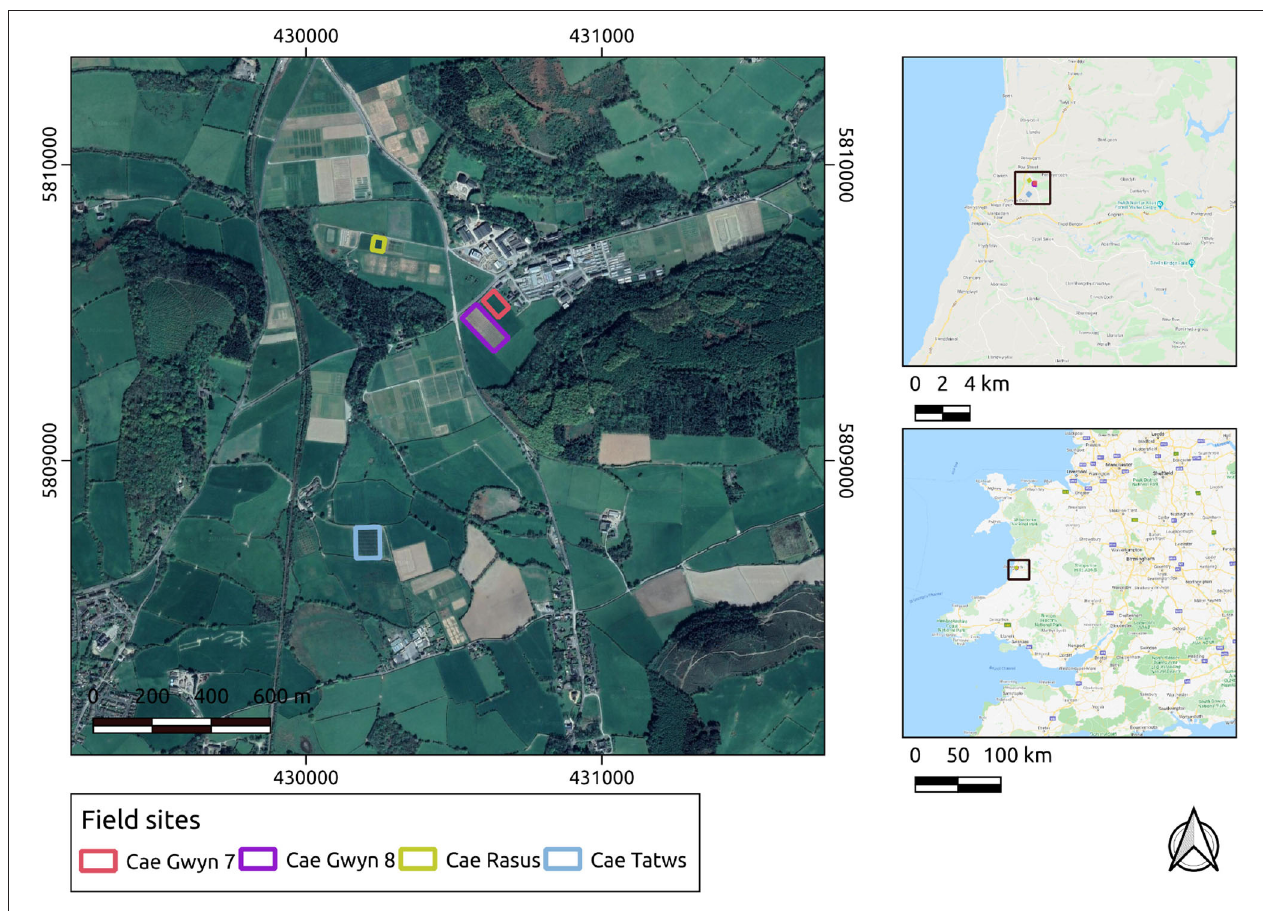
FIGURE 1 | Study sites in their local, regional, and national contexts. Basemap layers are provided by